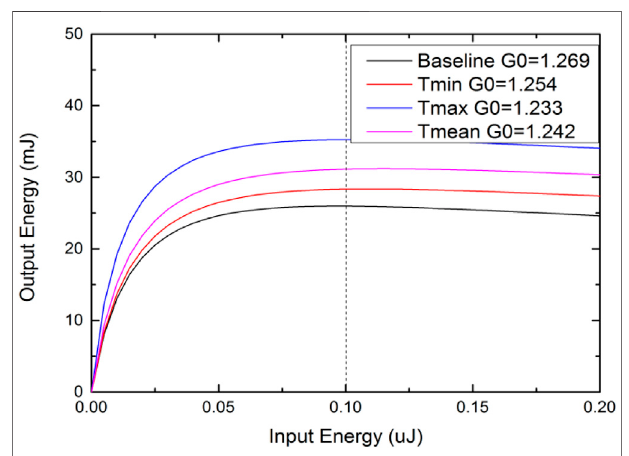
FIGURE 3 | Optimized energy curves of four con fi gurations.